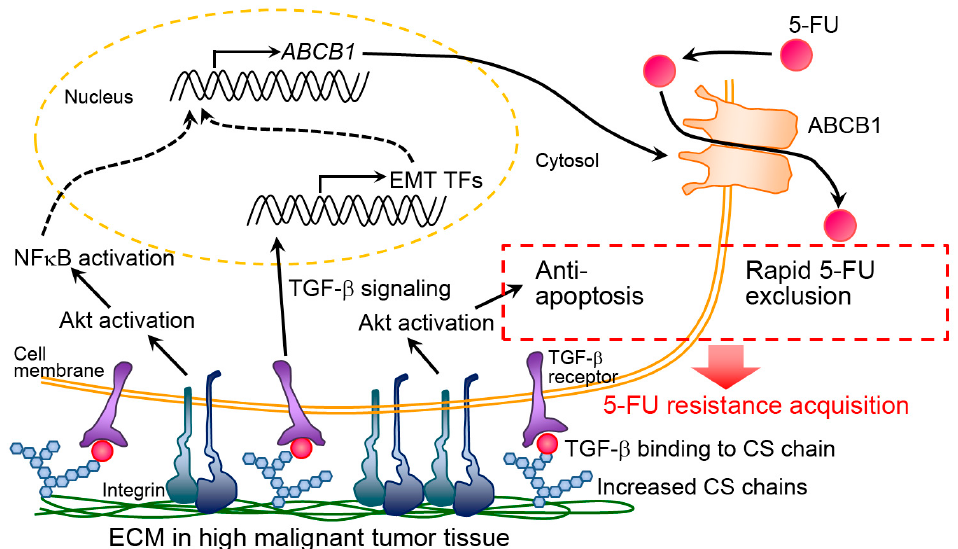
Figure 1. Putative molecular mechanism of chemoresistance acquisition by highly malignant extracellular matrix (ECM). CS and TF indicate chondroitin sulfate and transcription factor, respectively. This figure is reproduced from [77] with the permission of